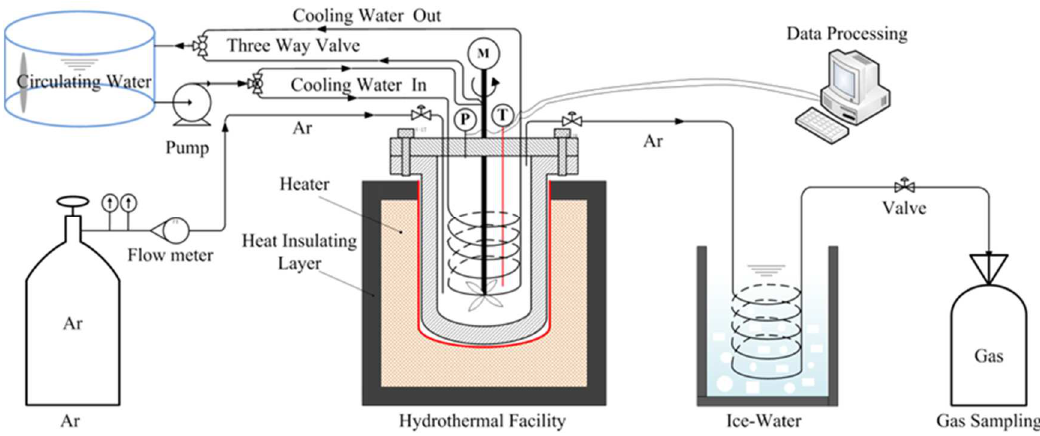
Figure 1. Schematic diagram of the equipment for hydrothermal dechlorination of PVC.